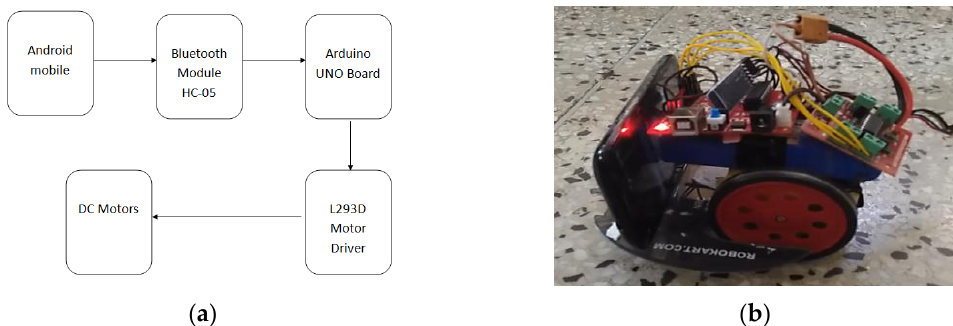
Figure 3. ( a ) Tele-operation of the master robot; ( b ) The master robot.